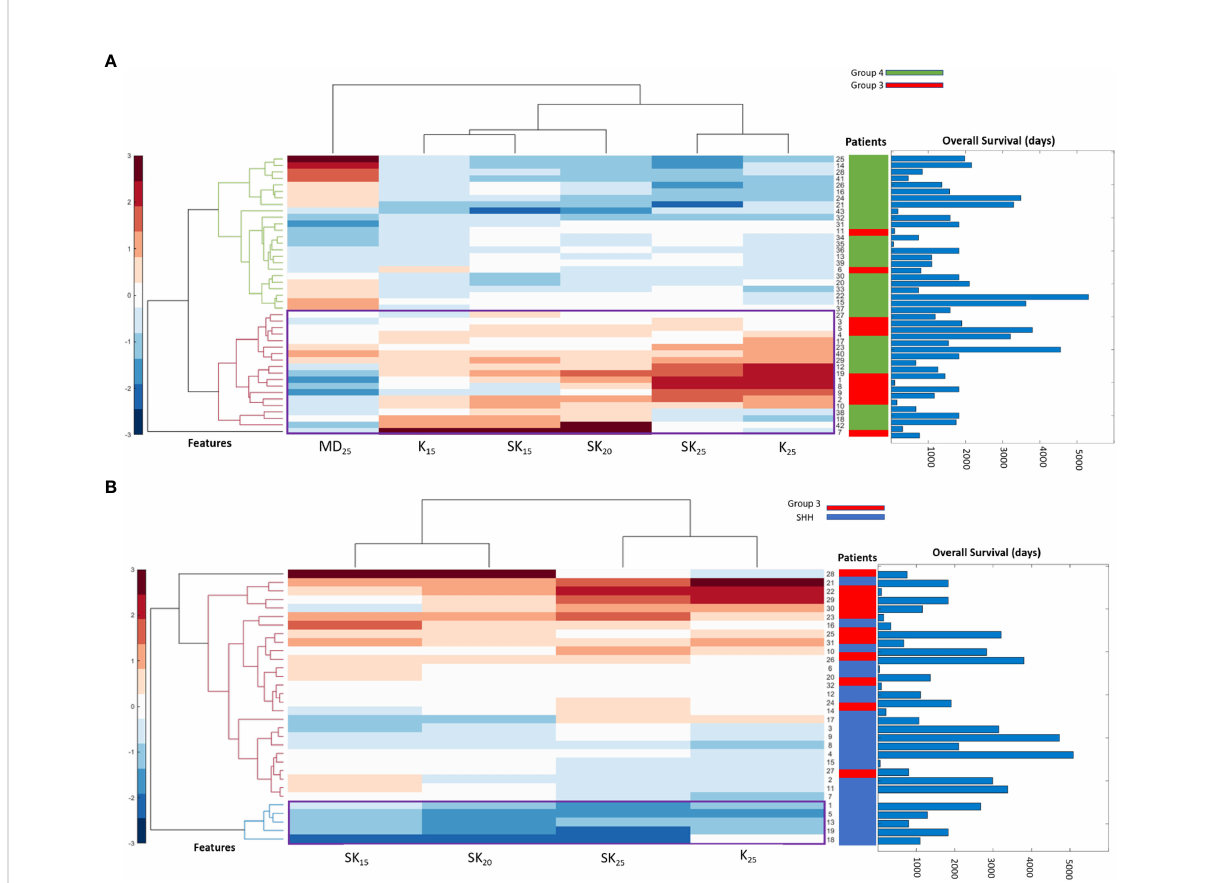
FIGURE 4 Hierarchical clustering of different MB subgroups based on the conducted ANOVA. In (A) , the statistically signi fi cant features between Group 3 and Group 4 were used to create a dendrogram that clusters the patients into their subgroups. Overall survival (OS) information for patients is also displayed, where patients clustered into Group 3 have lower OS than those clustered into Group 4. The statistically signi fi cant features between SHH and Group 3 are used in (B) to create a dendrogram that clusters the patients into their subgroups. OS information is also displayed for each patient, where Group 3 shows worse OS than SHH that is usually associated with better